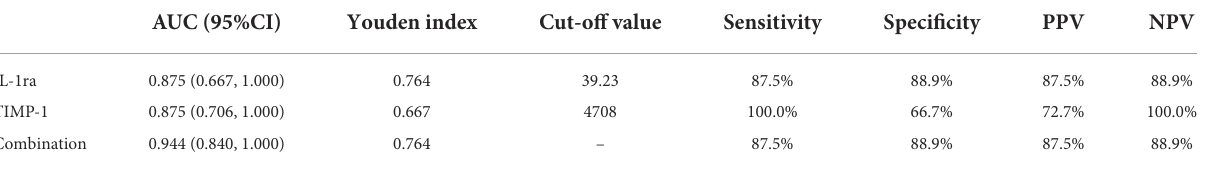
TABLE 4 Diagnostic value of serum cytokines/chemokines for distinguishing patients with DM and ASS. AUC (95%CI) Youden index Cut-off value Sensitivity Specificity PPV